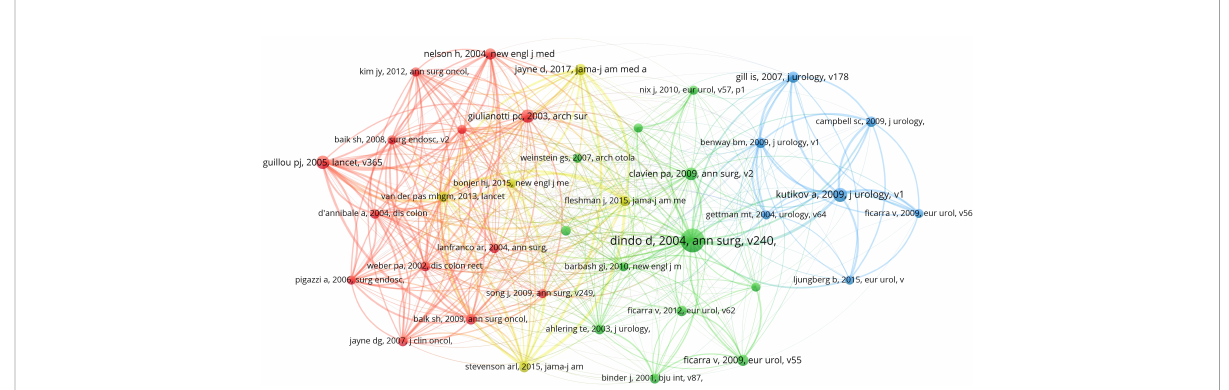
FIGURE 8 knowledge map of co-cited references network related to robotic surgery in oncology. The size and color of the nodes represent the citation frequency and different clustering, and the lines of the nodes and the thickness of the lines represent the co-citation relationship and co- citation strength of the references. From: